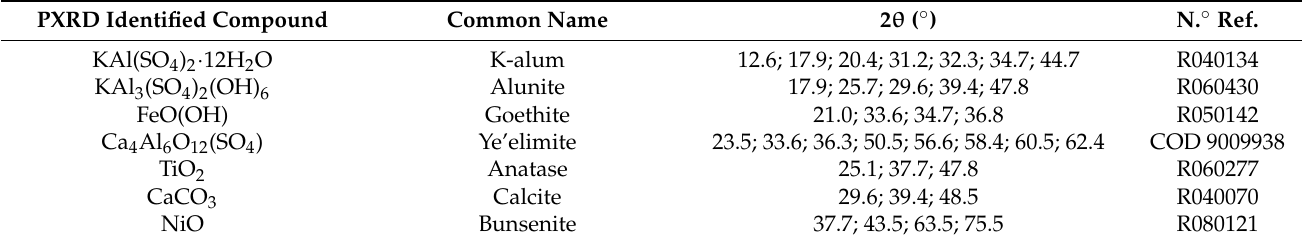
Table 2. Crystalline compound identified in PXRD spectra of the book paper (before and after deacidification). PXRD Identified Compound